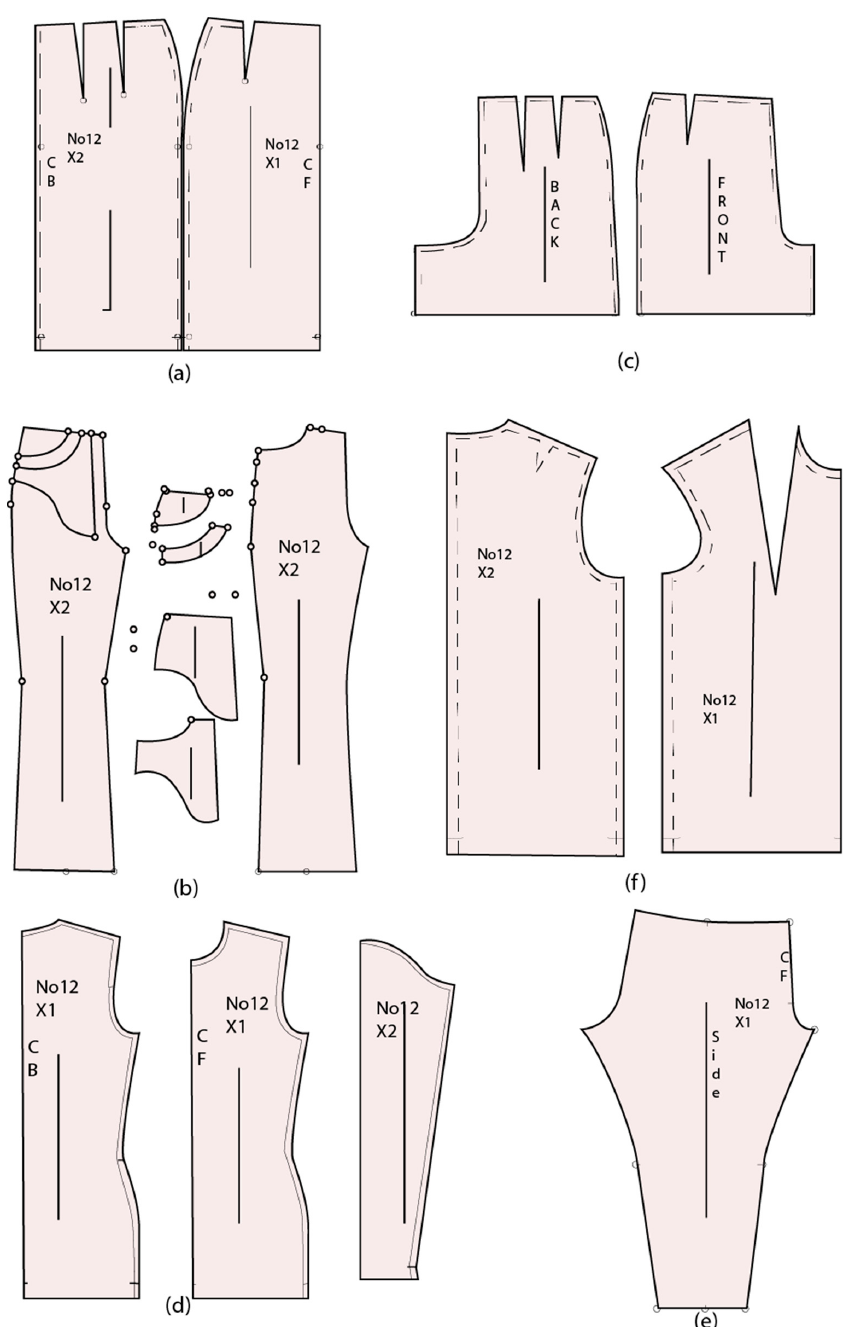
Figure 1. Polypattern computer-aided design (CAD): basic skirt ( a ), basic trousers ( b ), culottes ( c ), track-suit top ( d ), tracksuit trousers ( e ), close-fit bodice block ( f ).